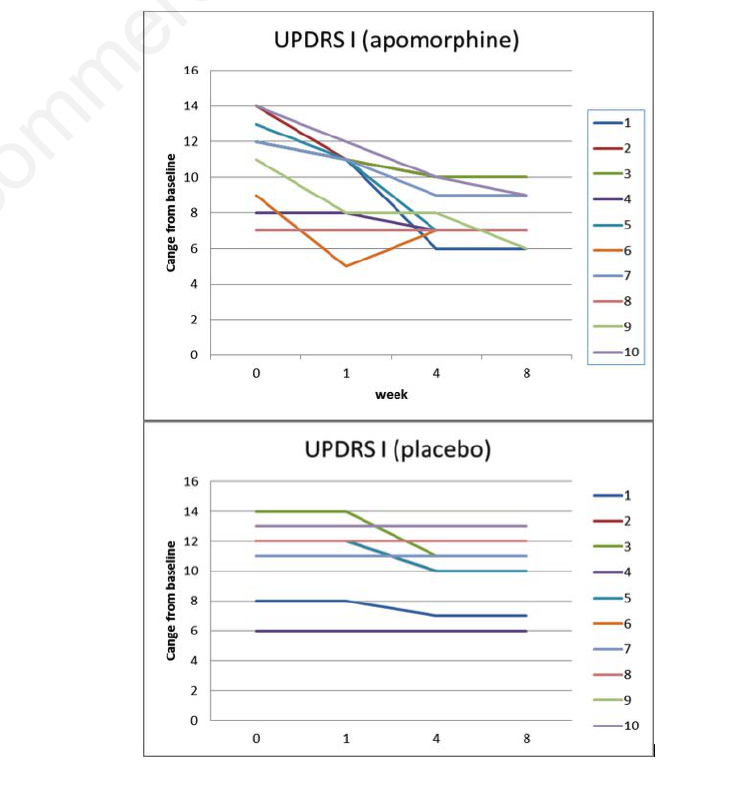
Figure 1. Total scores change from baseline over time (weeks) in UPDRS part I. Apomorphine and